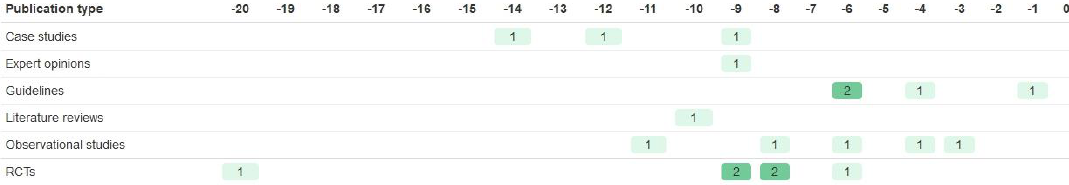
Figure 6. Evidence cited by the NCT02664350 trial to justify inclusion of the CYP2D6 biomarker, relative to the publication of the 2018 design and rationale paper